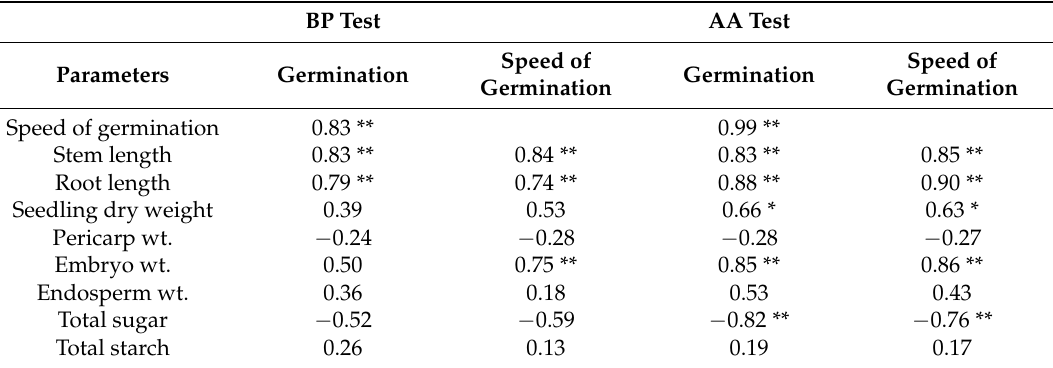
Table 4. Correlation among germination parameters with total sugars and starch contents under BP test and AA test ( n = seven inbred lines and four